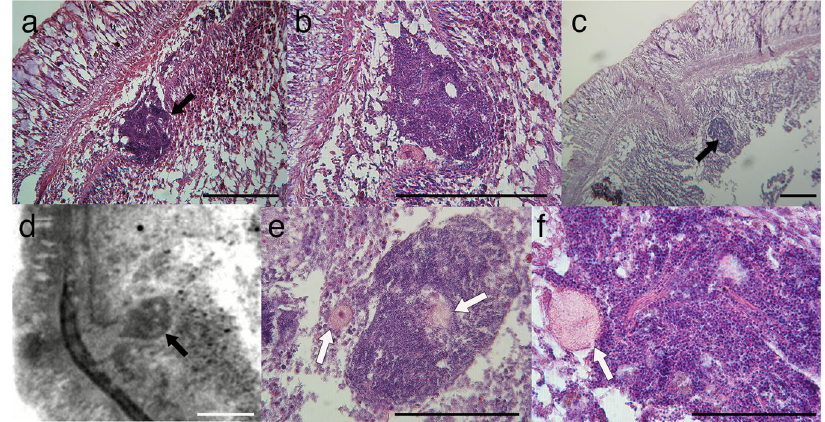
Fig. 6 Sperm inside Xenoturbella bocki . a , b Sperm cluster located on the surface of the gut. c , d Sperm cluster situated within the gastrodermal cells. e , f Sperm clusters with oocytes within or near the clusters. Black arrows: sperm clusters, white arrows: oocytes. Scale bars: a – d : 200 μ m; e , f : 100 μ